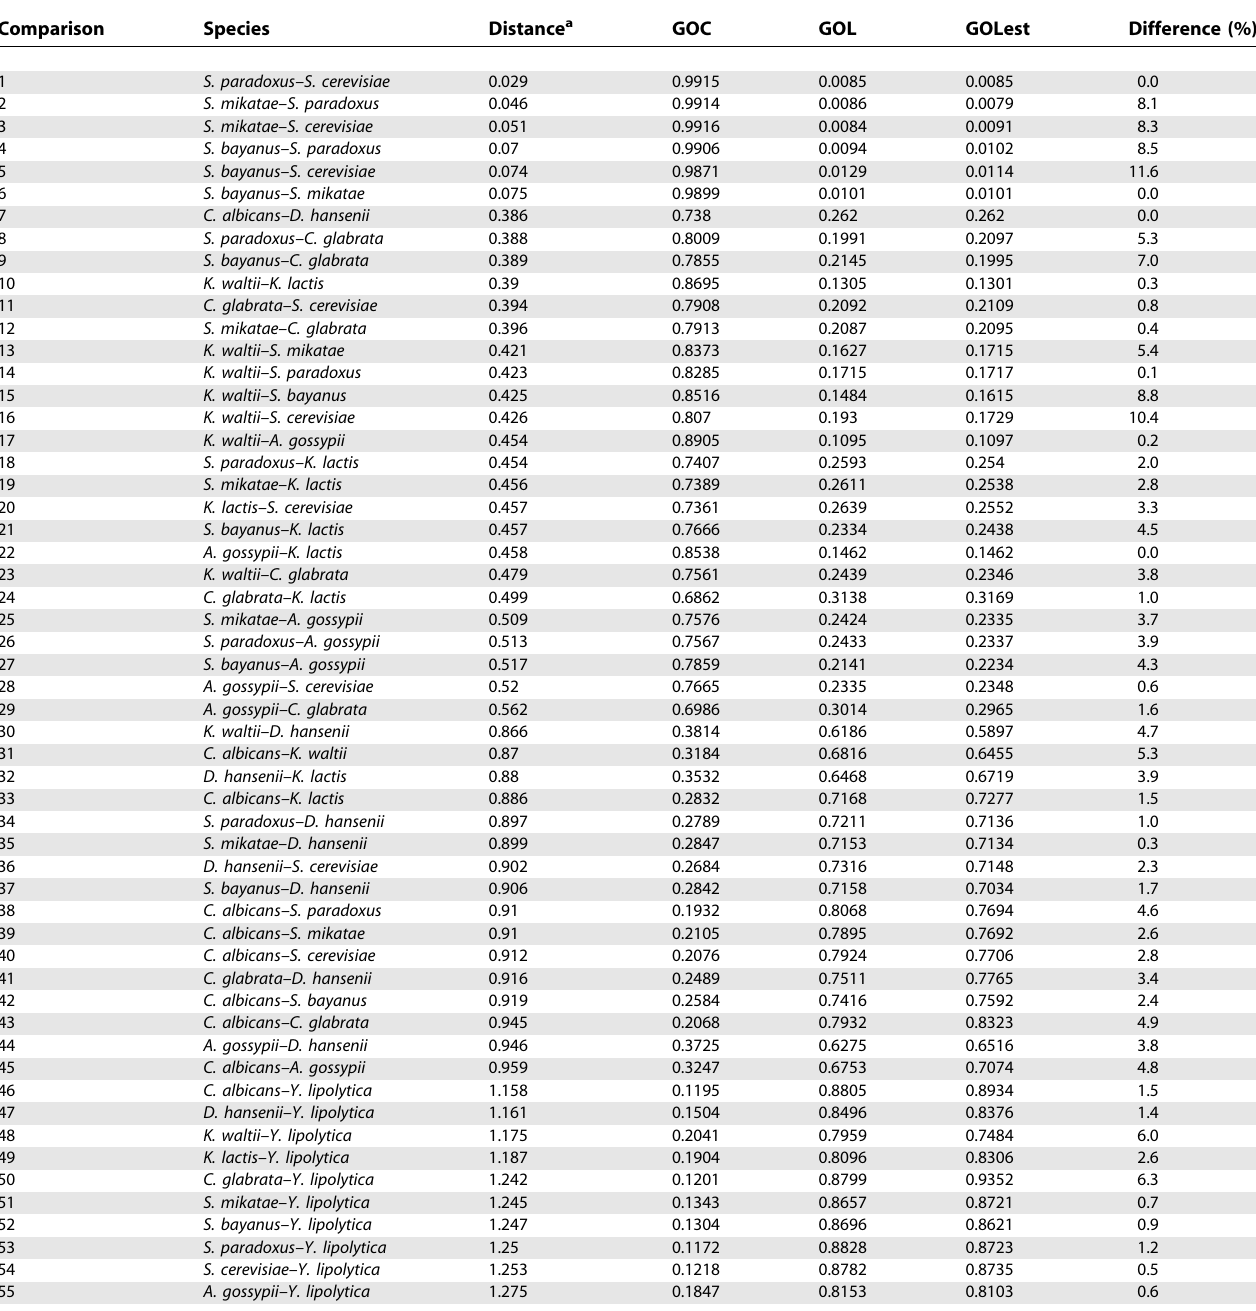
Pairwise comparisons are ordered by increasing phylogenetic distances. a Distances correspond to the sum of the branch lengths separating two species from their last common ancestor. DOI: